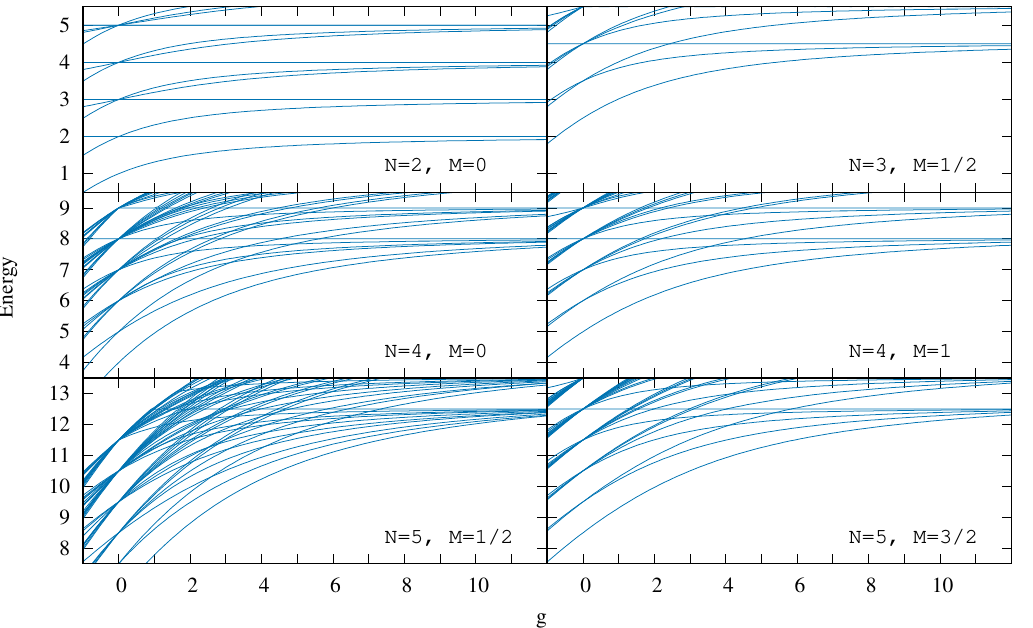
Figure 8. Low-energy spectrum for several number of particles and spin configurations as a function of the interaction strength. Notice that the excitation energies are measured with respect to the ground-state energy of the non-interacting